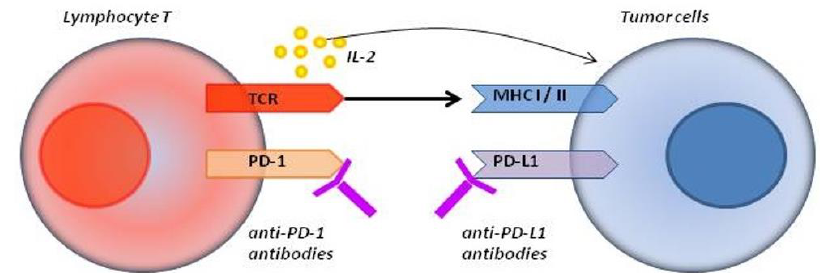
Figure 1. The blocking of programmed cell death 1 (PD-1) molecules (with anti-PD-1 antibodies) or PD-L1 molecules (with anti-PD-L1 antibodies) restores the cytotoxic function of T lymphocytes [15,16].